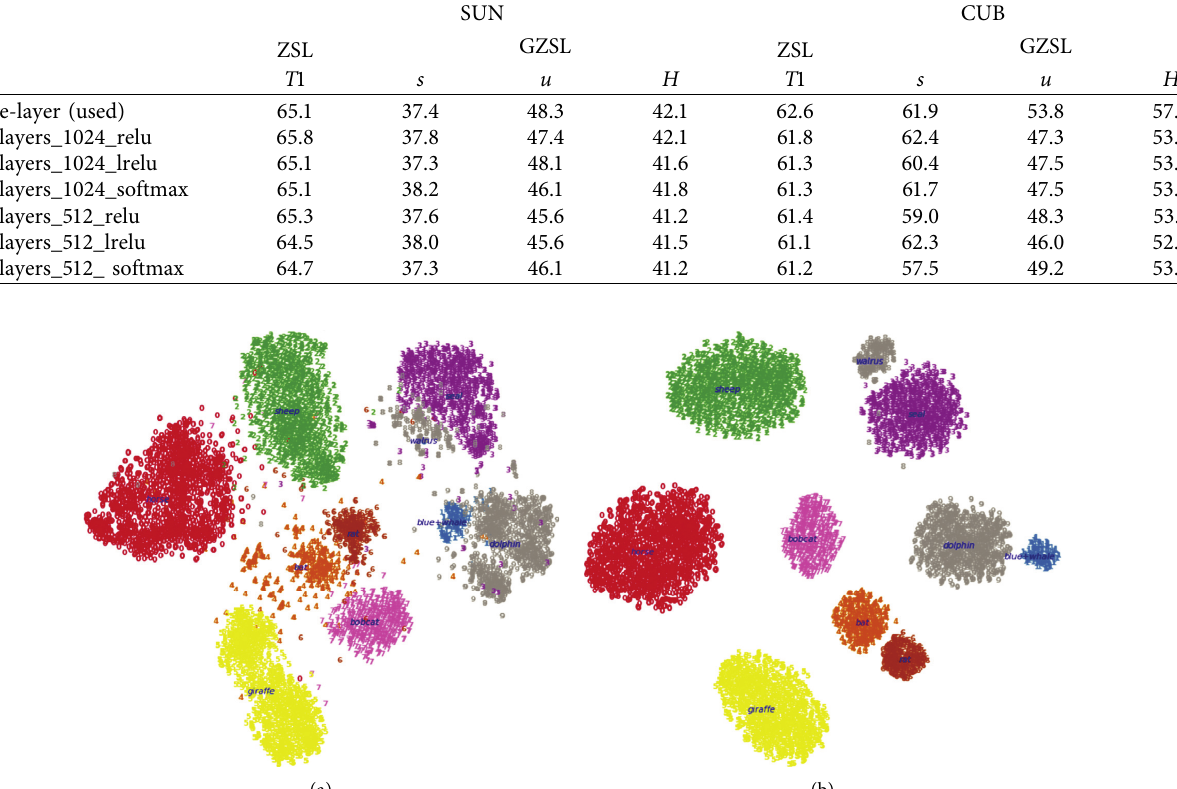
Figure 6: . SNE visualization of real (a) and synthetic (b) image features for unseen classes in AWA2